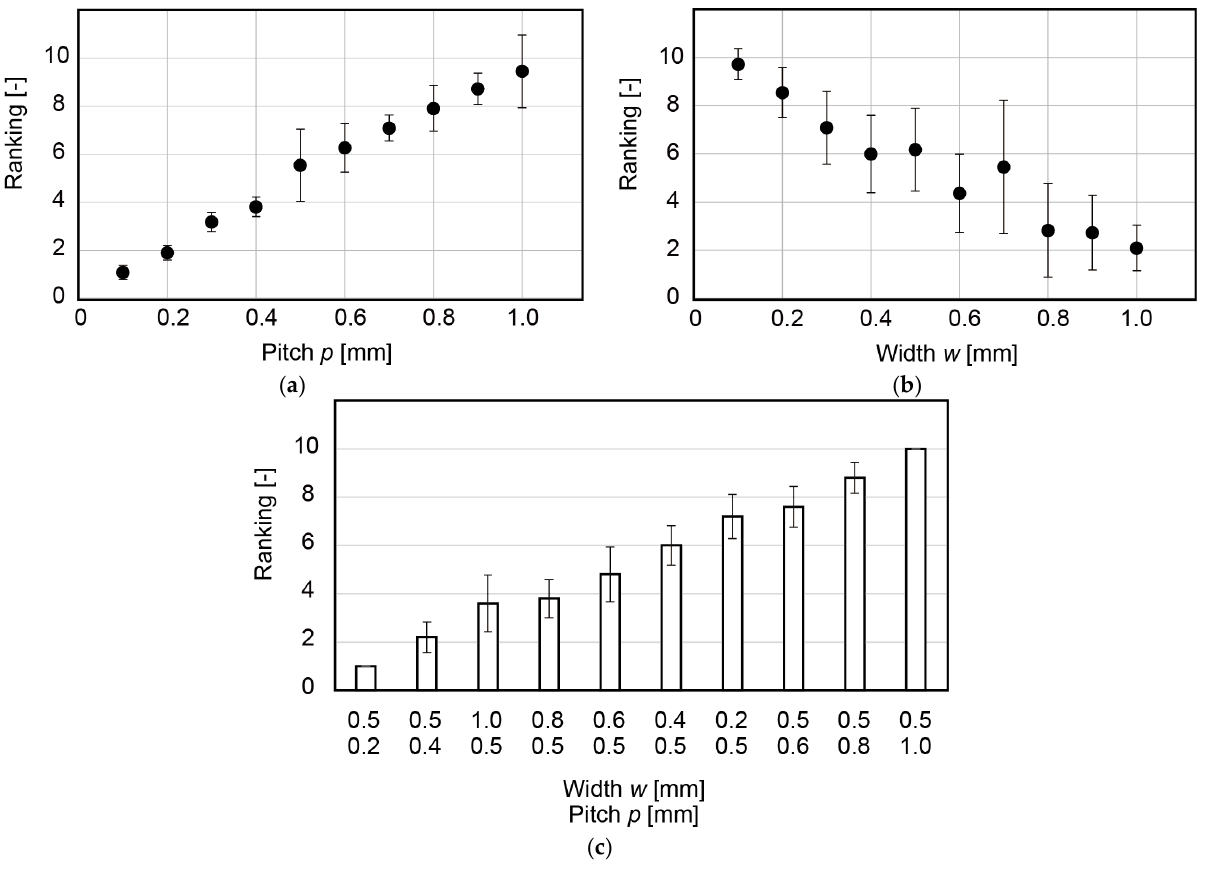
Figure 4. Ranking of roughness feeling for ( a )  -constant samples, ( b )  -constant samples, and ( c ) mix of  - and  -constant samples. ( c ) mix of w - and p -constant samples.